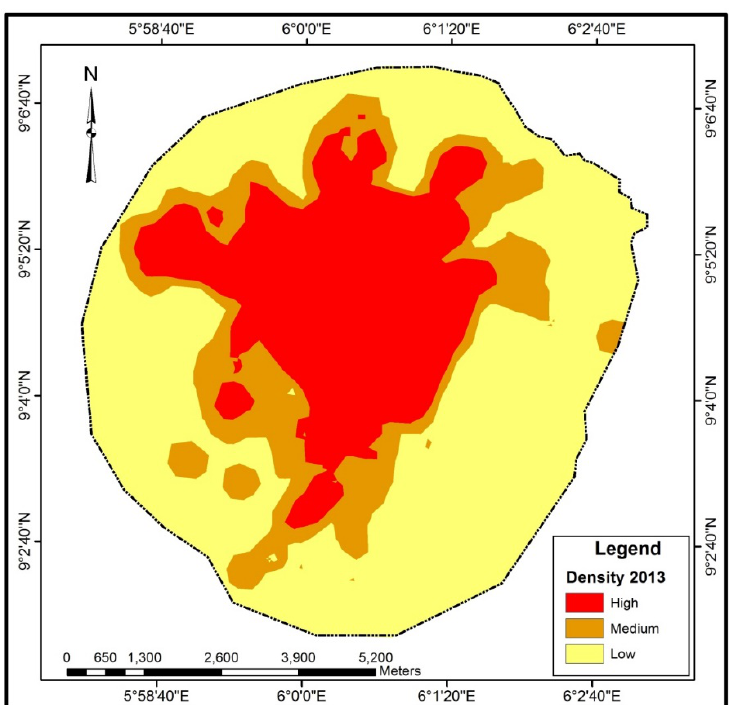
Fig. 7. Residential density classification for the year 2013 (Developed by the authors,